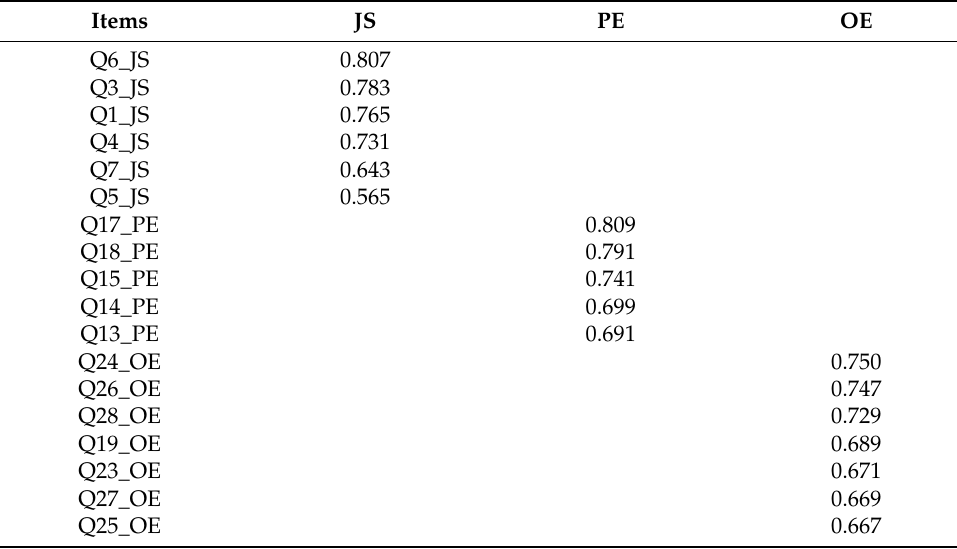
Table 11. Component matrix per construct.